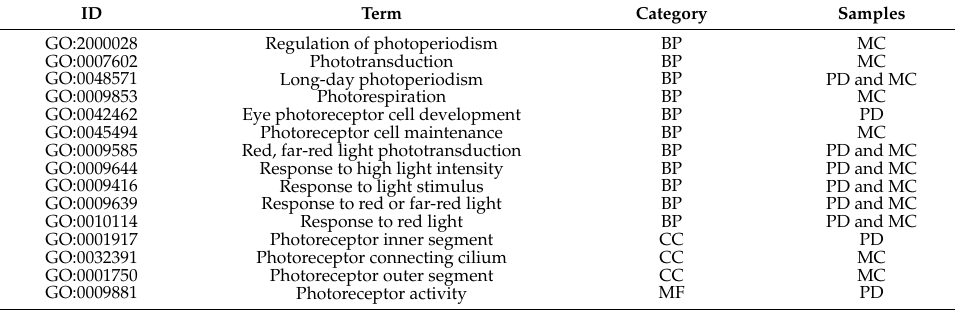
Figure 3. The top 30 GO enrichment terms among DEGs. ( a ) The statistical analysis of GO terms. ( b ) The top 30 GO enrichment terms. The green bars represent biological processes, the red bars represent molecular functions, and the blue bars represent cellular components. Table 4. GO enrichment terms related to light (mycelia vs. primordium).